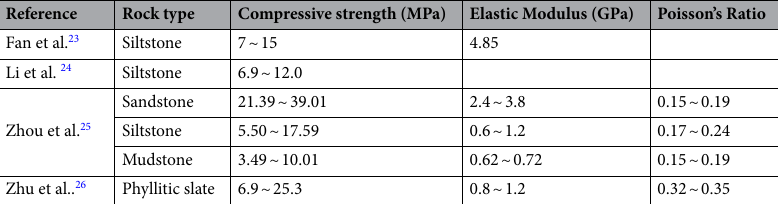
Table 1. Mechanical properties of soft rock measured in previous